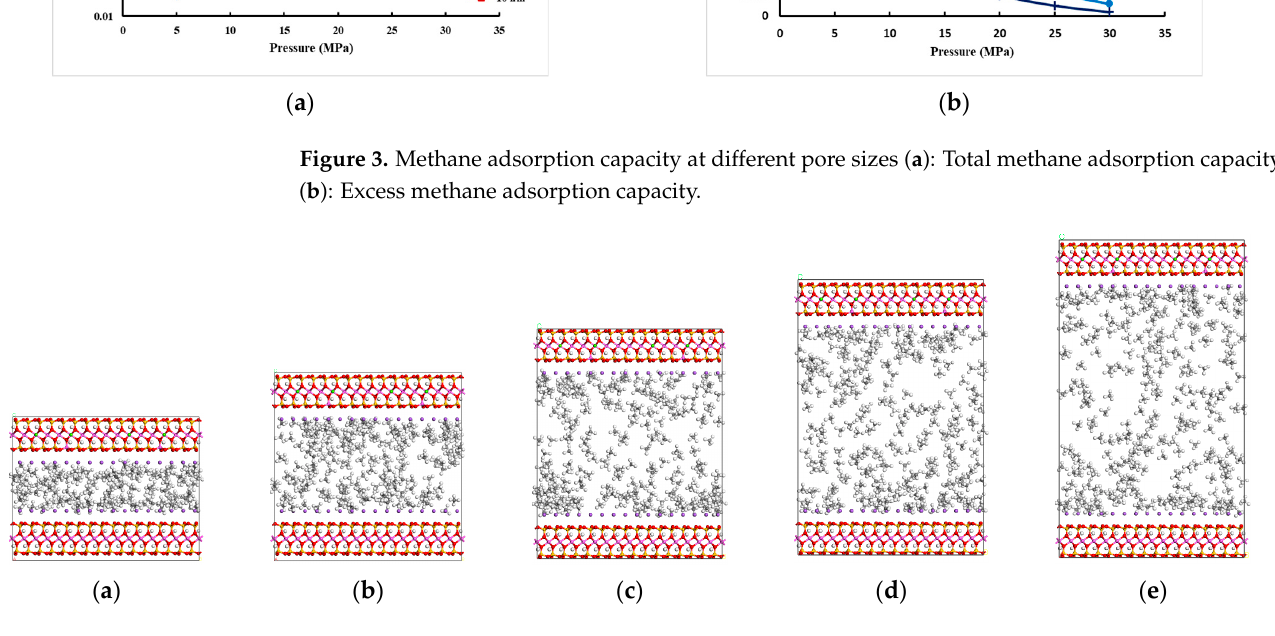
Figure 4. Partial pore size montmorillonite 3D conformation ( a ): 1 nm, ( b ): 2 nm, ( c ): 3 nm, ( d ): 4 nm, ( e ): 5 nm.